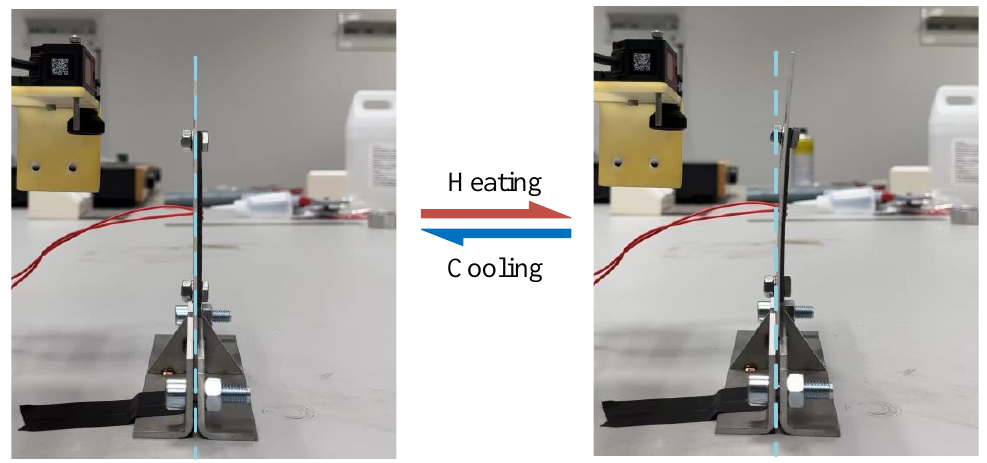
Figure 7. SMA-based actuator